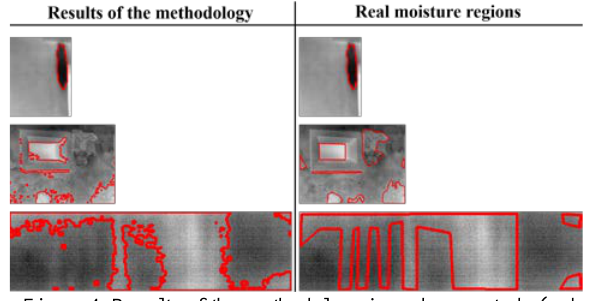
Figure 4. Results of the methodology in each case study (red lines), representing on the right side of each result the corresponding real moisture regions (red lines). From top to bottom: Test_1, Test_2 and Test_3 To quantify the qualitative results, the following performance metrics (values in percentage) are defined: